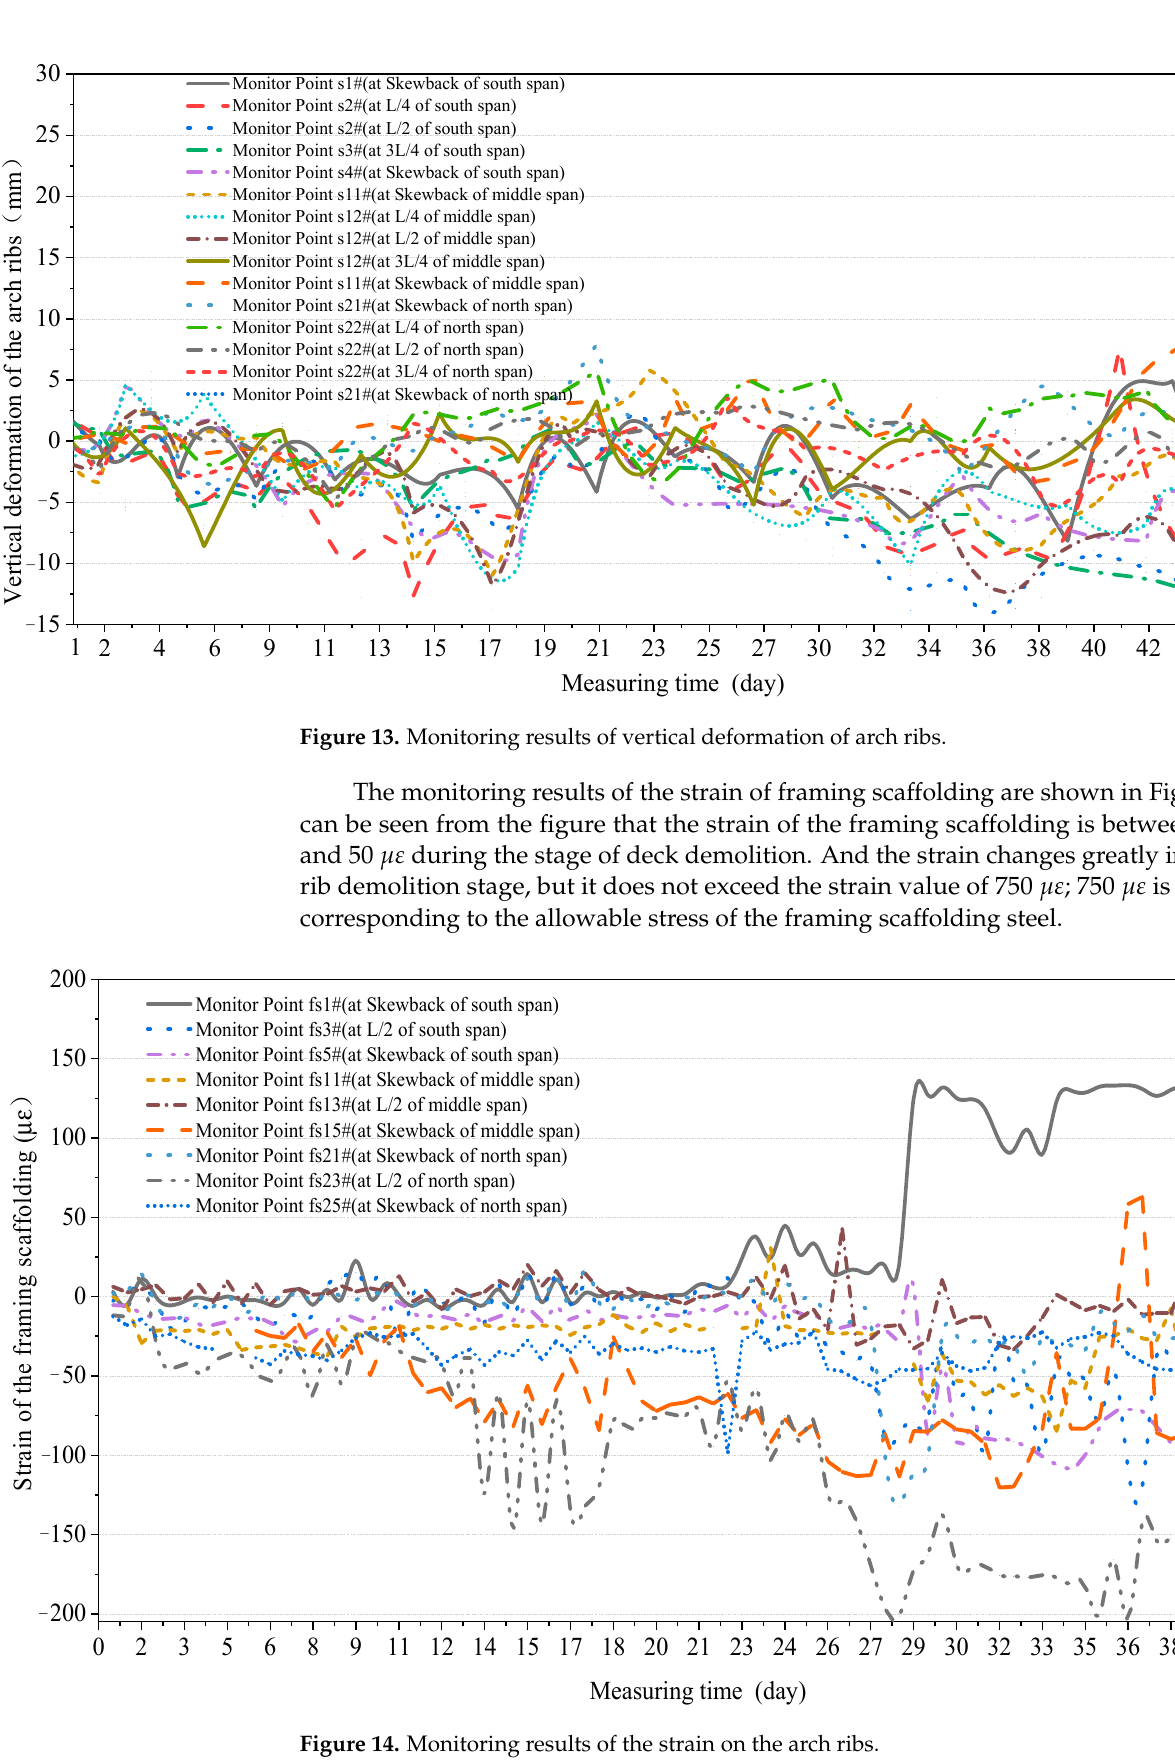
Figure 12. Monitoring results of the strain on arch ribs.